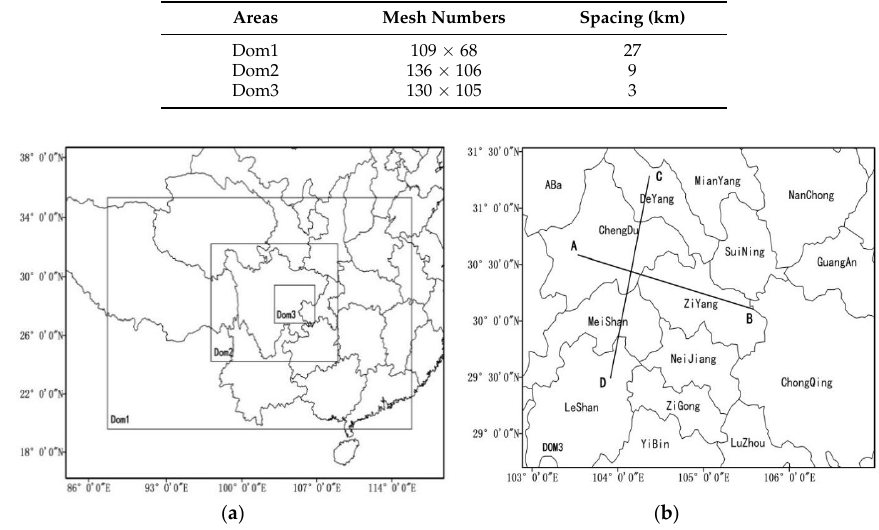
Figure 6. The three nested areas ( a ) and innermost area ( b ) of simulation using weather research forecasting model with chemistry (WRF–CHEM) (notes: the red dot in ( b ) signifies the automatic air monitoring substation in Sichuan Province, and the green dot in ( b ) signifies the comprehensive substation at the Chengdu University of Information